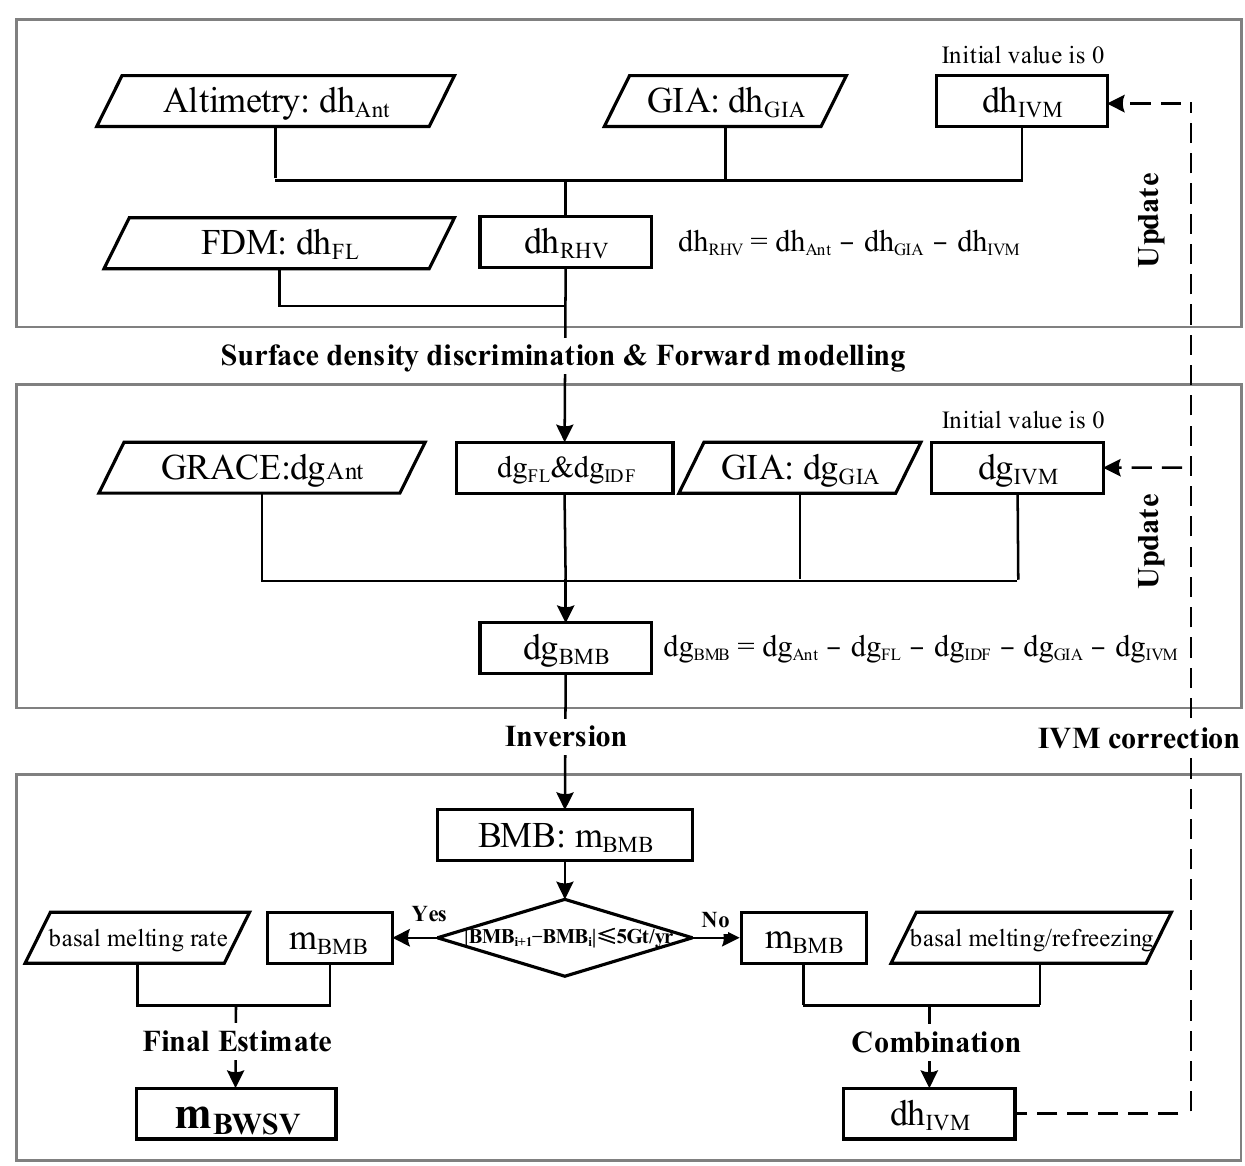
Figure 2. Flowchart for estimating BMB and BWSV. In upper pane, initial values of dg (cid:2890)(cid:2896) and dg (cid:2893)(cid:2888)(cid:2890) are calculated through surface density discrimination and gravity forward modelling method. In middle pane, dg (cid:2886)(cid:2897)(cid:2886) are abstracted from the total gravity variations dg (cid:2885)(cid:2924)(cid:2930) , and be used to calculate m BMB through layered gravity inversion method. In lower pane, m BMB and basal melting data are combined to obtain dh IVM , then the obtained dh IVM are used to update the relevant variations in the first step for iteration until the BMB result is stable.